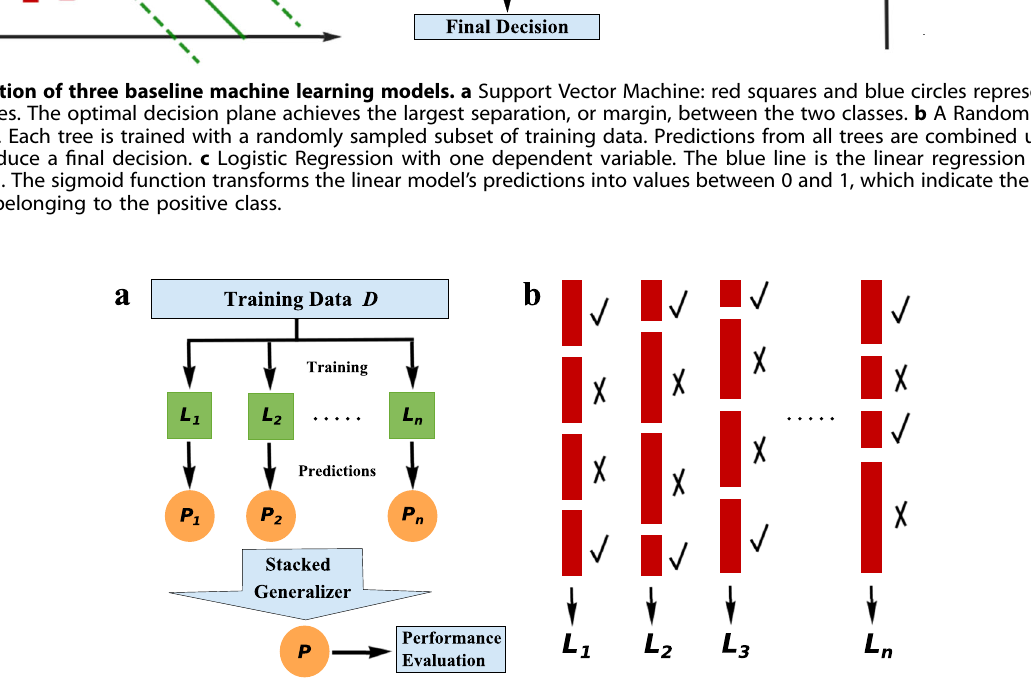
Fig. 2 Illustration of ensemble learning and adaptive boosting. a Ensemble learning: L 1 , L 2 , … , L n are independent learners trained on the entire training data D . The stacked generalizer is a logistic regression model trained to produce a fi nal prediction P based on the decisions from individual classi fi ers. Model performance is measured using the fi nal predictions. b Adaptive boosting: checkmarks and crosses indicate correctly and incorrectly classi fi ed instances, respectively. The heights of the rectangles are proportional to the weights of the training instances. A sequence of learners, L 1 , L 2 , … , L n , is generated with each new model trained on a re-weighted dataset, which boosts the weights of the misclassi fi ed training instances in the previous model.